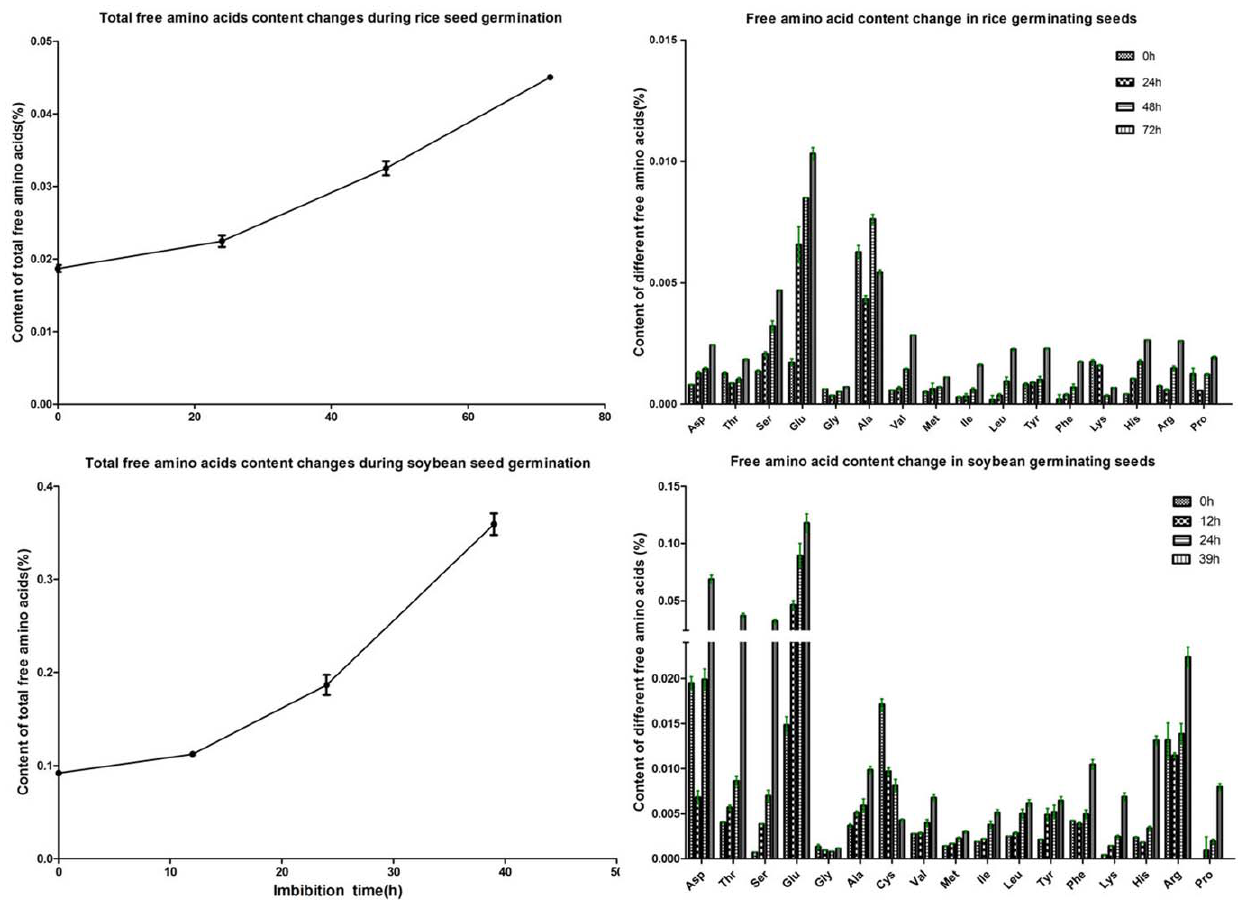
doi:10.1371/journal.pone.0056947.g005